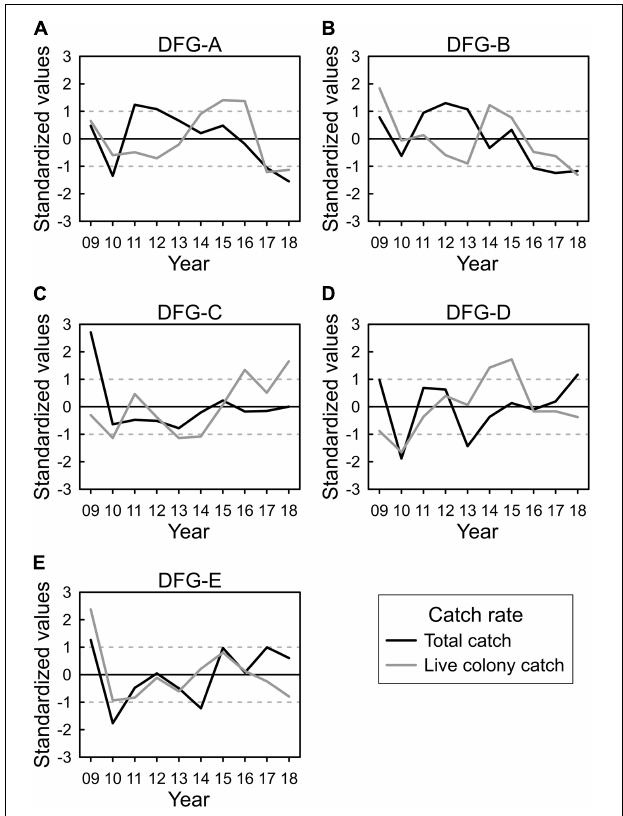
FIGURE 7 | (A–E) Annual total and live colony catch rates (standardized using the average and standard deviation) in the five DFGs of the Taiwanese precious coral fishery between 2009 and 2018 (dashed lines: ± 1 standard